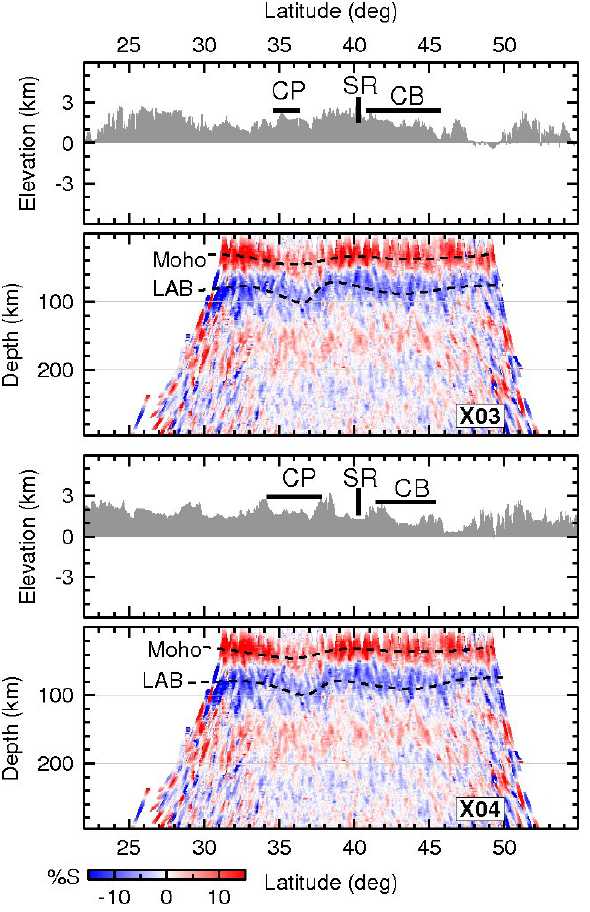
Fig. 14. Migrated S receiver functions along profiles X03 and X04 as in Fig. 3.